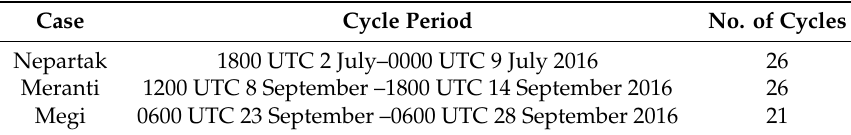
Table 2. List of start and end date of each case used in the